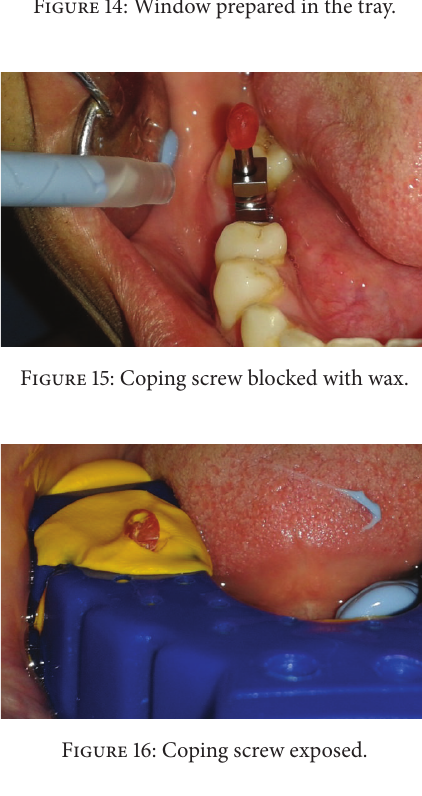
Figure 18: PVS impression without